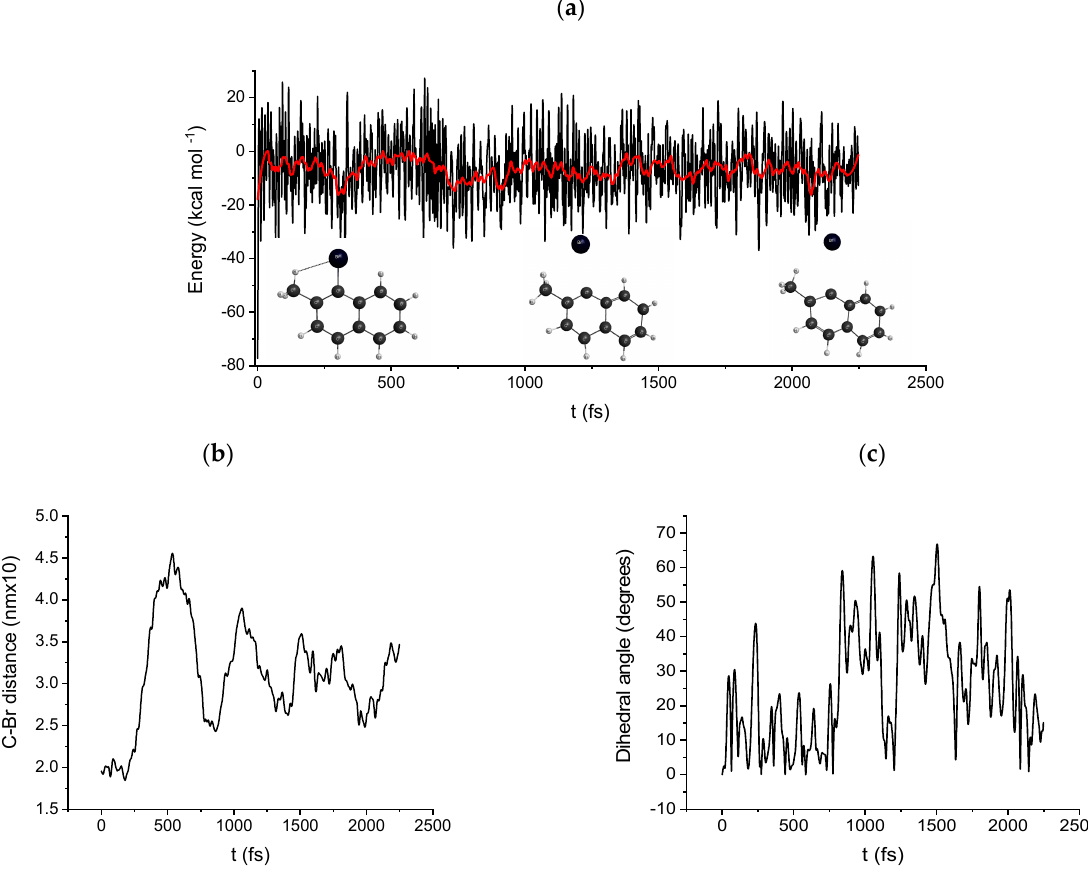
Figure 5. Path B DRC results, B3LYP/6-31G(d) 1-Br-2-naphtol DRC trajectory for the doublet radical anion ( 2 ), ( a ) molecular electronic potential energy vs. time, ( b ) Carbon bromine distance as a function of time, ( c ) dihedral angle between the dissociating C − Br bond and the aromatic plane as a function of time.